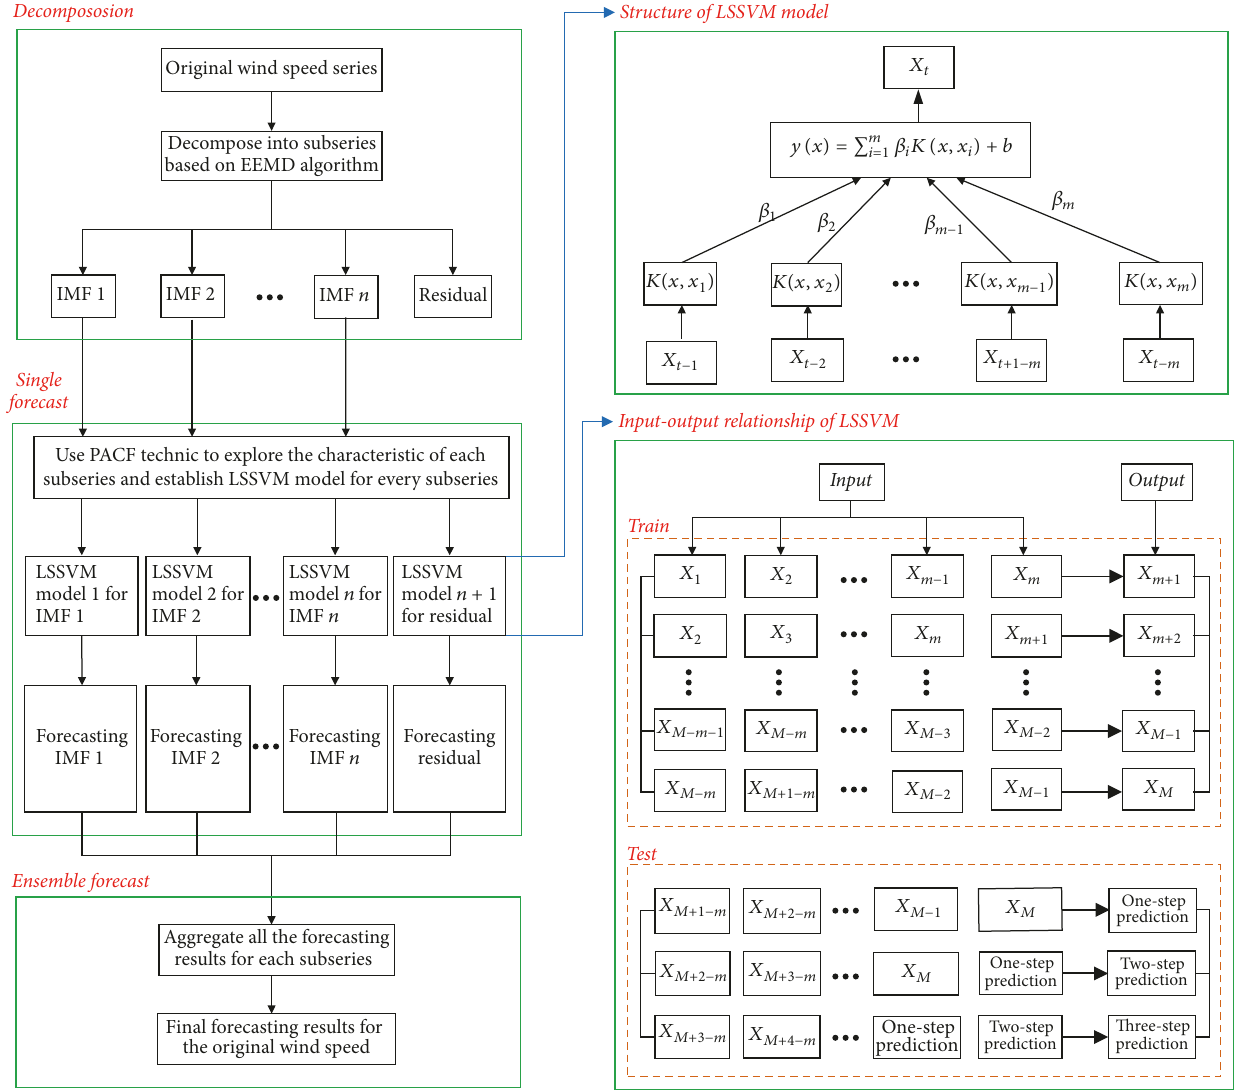
Figure 2: The flowchart of hybrid EEMD-LSSVM wind prediction